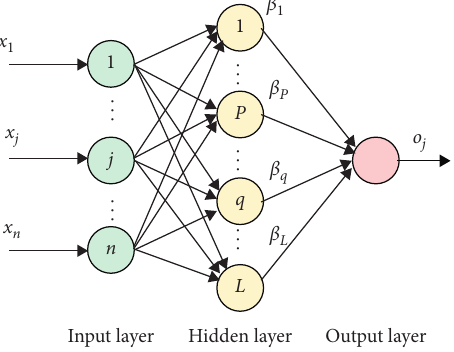
Figure 5: The neural network structure of extreme learning machine